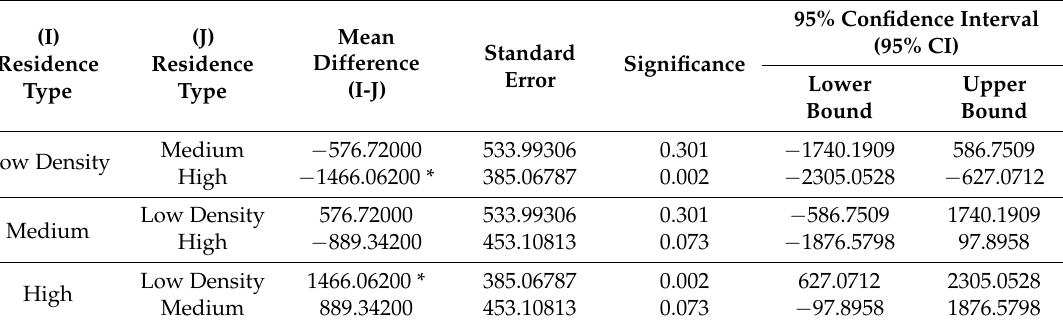
Table 4. Variance in PM in concentration.